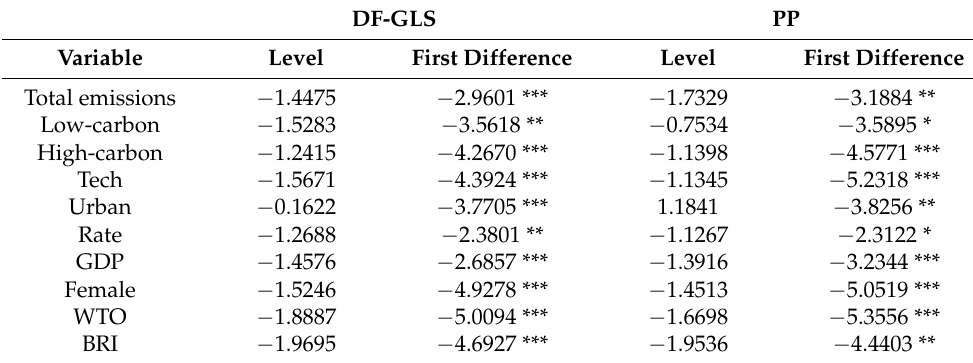
Table A2. Results of unit root